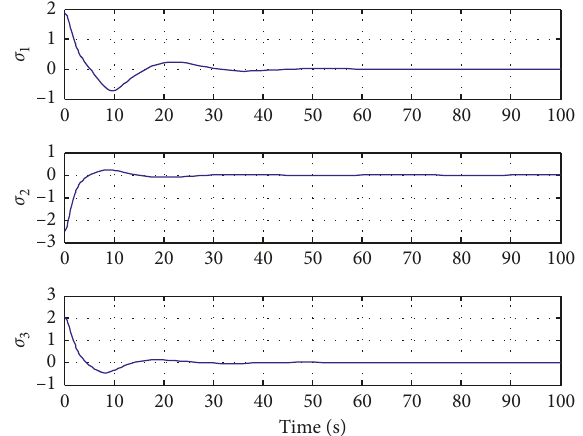
Figure 4: Time response of attitude σ when Φ � 320 ∘ after saturation.